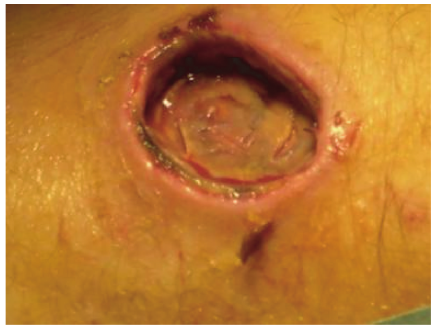
Figure 4: Intraoperative picture following d´ebridement of the es- char showing the full thickness skin damage without any cement extrusion